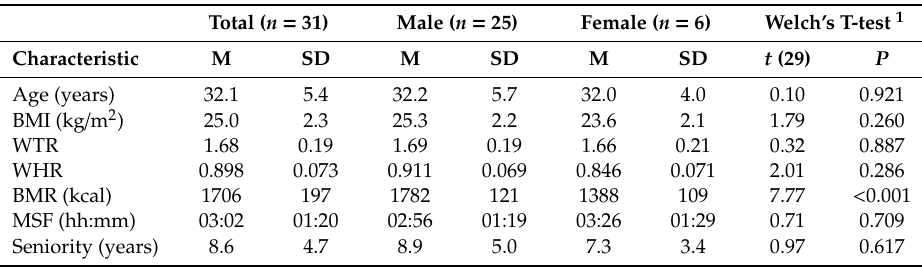
Table 1. Participants’ characteristics overall and by